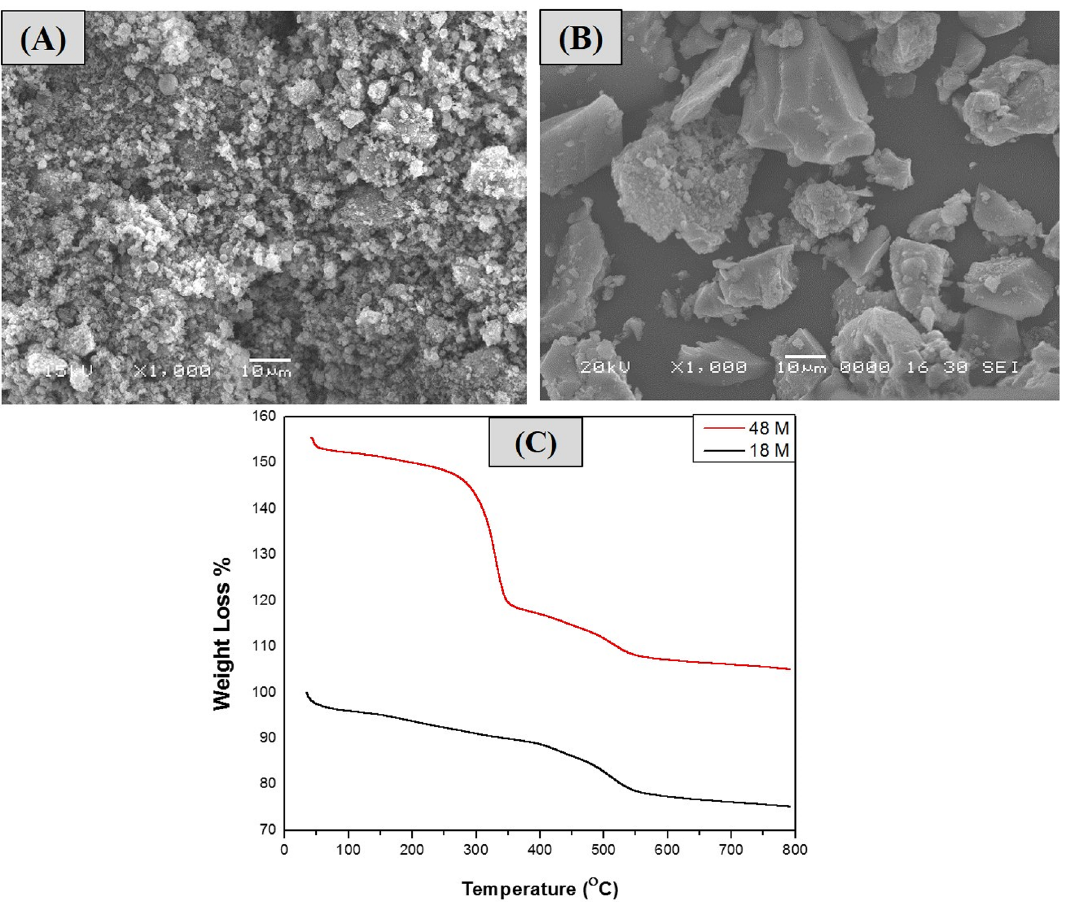
Figure 4. SEM images of ( A MT18, B MT48), and ( C ) thermogravimetric analysis (TGA) of both MT18, MT48.